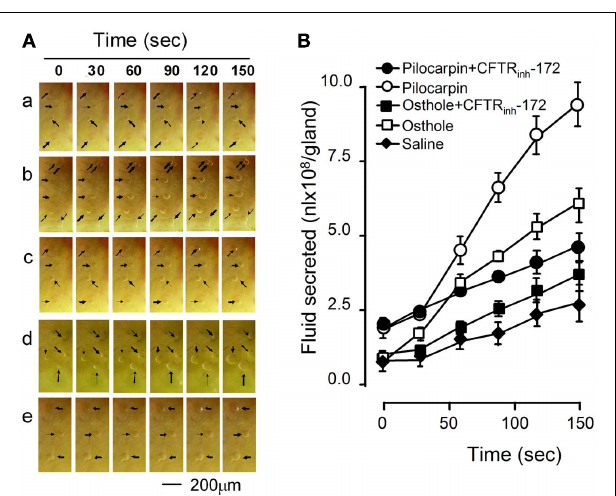
FIGURE 3 | Stimulation of mucosal Cl − current of rat colon by osthole. Osthole-stimulated transepithelial Cl − current was measured after inhibition of Na + current by amiloride (10 μ mol/L) and prostaglandin production by indomethacin (10 μ mol/L).